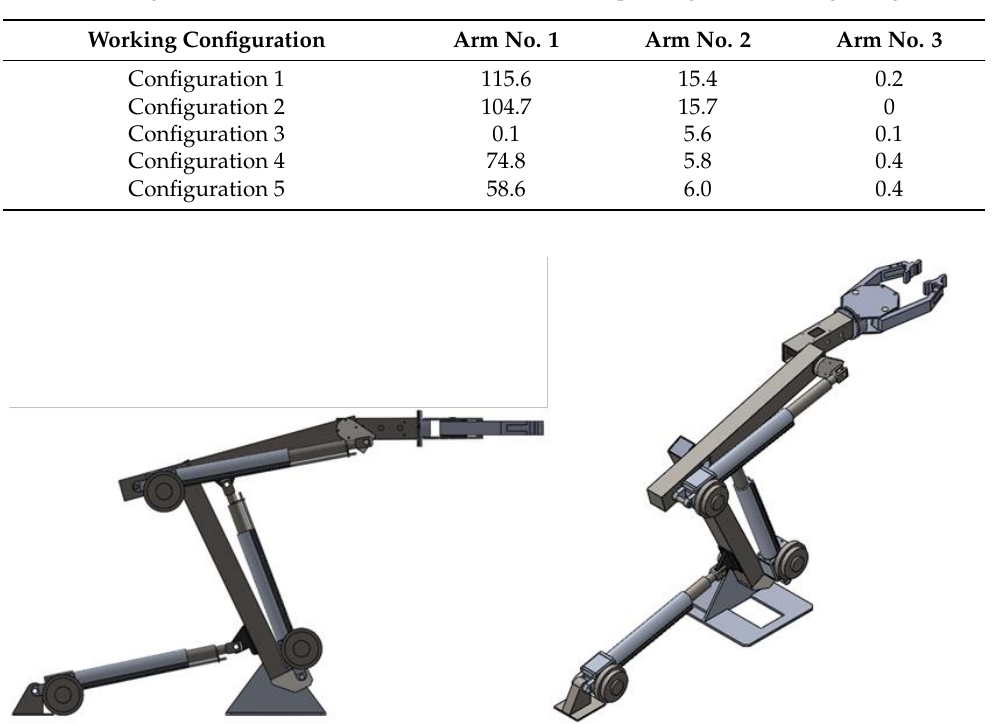
Table 2. The angles of the three elements of the robotic arm, corresponding to the working configurations.